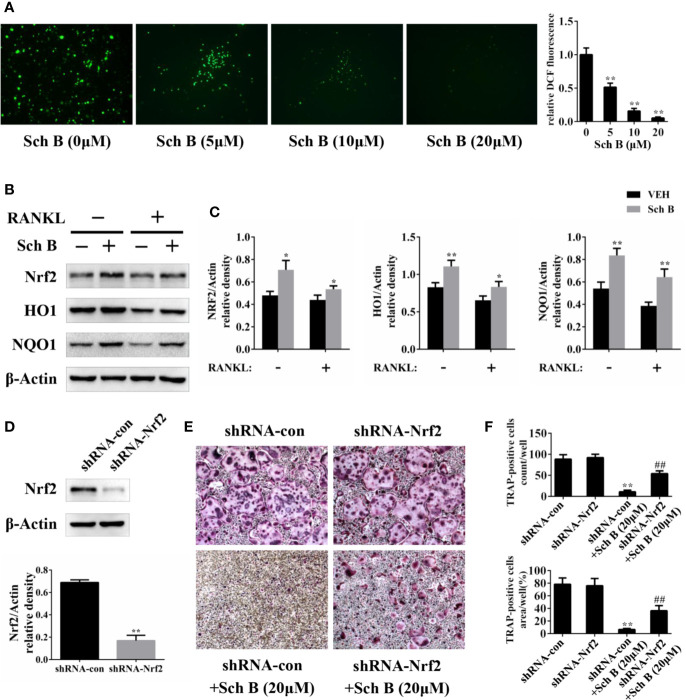
Schisandrin B inhibits oxidative stress and activates Nrf2 signaling. (A) Bone marrow macrophages (BMMs) were treated with the indicated concentrations of Schisandrin B in the presence of macrophage colony stimulating factor (M-CSF) and receptor activator of nuclear factor-κB ligand (RANKL) for 2 days. Cellular reactive oxygen species (ROS) levels were evaluated and quantified. (B, C) BMMs were treated with or without Schisandrin B (20μM) in the absence or presence of RANKL for 3 days. The protein was extracted for Western blotting. (D) Knockdown efficacy of adenoviral transduction. BMMs were infected with the adenovirus carrying Nrf2 shRNA or the control adenovirus for 3 days, and the expression of Nrf2 was measured using western blotting. (E, F) BMMs were treated with Schisandrin B (20μM), the adenovirus carrying Nrf2 shRNA, and the control adenovirus as indicated. After 5 days, TRAP staining was conducted. The data were confirmed by three independent experiments and are expressed as means ± SD. *P < 0.05, **P < 0.01 versus the vehicle. ##P < 0.01 versus the shRNA-con+ Schisandrin B (20μM) group.